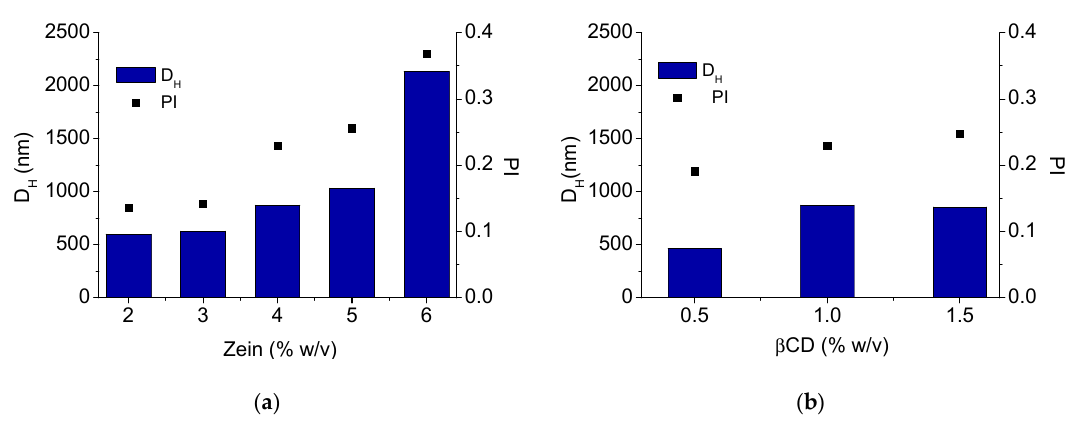
Figure 2. Size and polydispersity (PI) of zein/ β CD pseudolatexes. Effect of zein concentration (2–6% w / v ) at a fixed β CD concentration (1% w / v ) ( a ); effect of increasing β CD concentration (0.5–1.5% w / v ) at a fixed zein concentration (4% w / v ) ( b ). D H : hydrodynamic diameter.